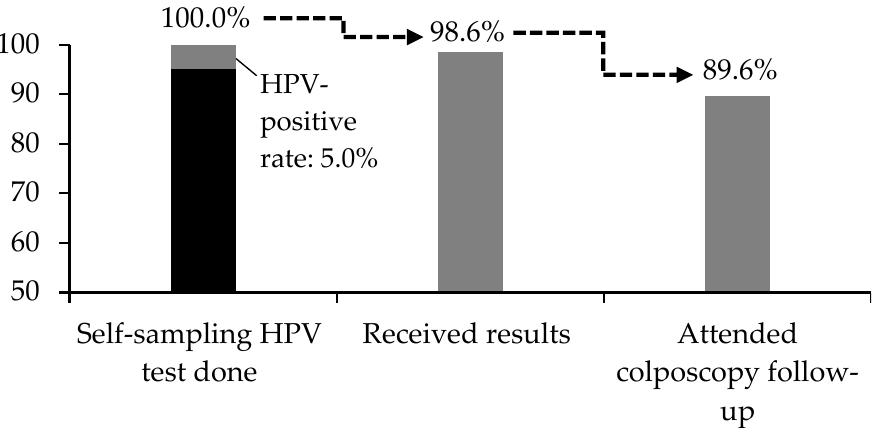
Figure 2. Linkage to care among women who were screened positive for self-sampling HPV test under Pilot Project ROSE. A total of 4188 women were screened and 99.7% had a valid HPV test result. The positive rate was 5.0%. Almost 99% of HPV-positive women confirmed receipt of test results and 89.6% attended colposcopy follow-up.